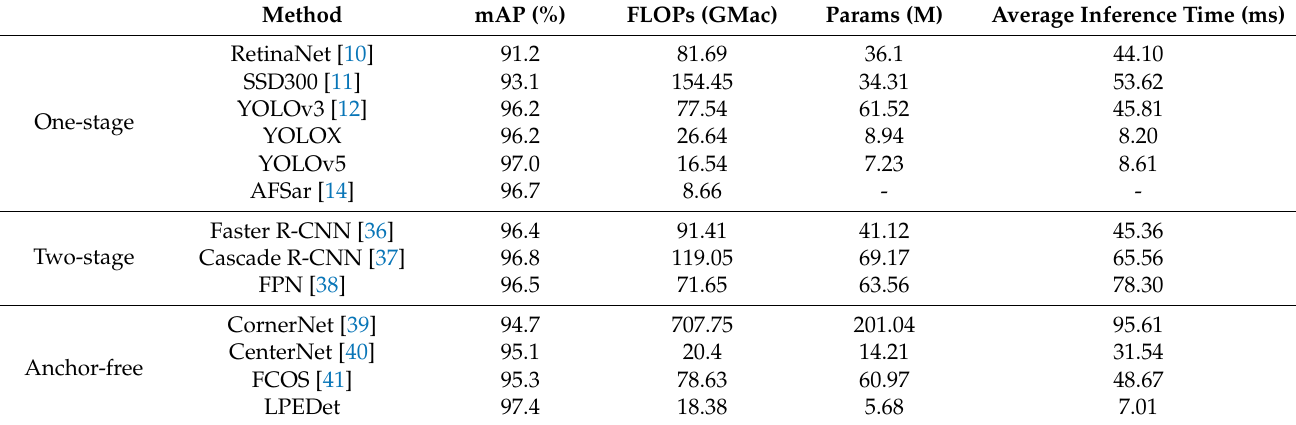
Figure 6. Visualization effect of the ablation experiment. The purple box is the target that was missed when marked, the red box is the target of misdetection and the blue box is a missed target. CA = coordinate attention; PEA = position-enhanced attention. Table 4. Comparison with the latest target detection